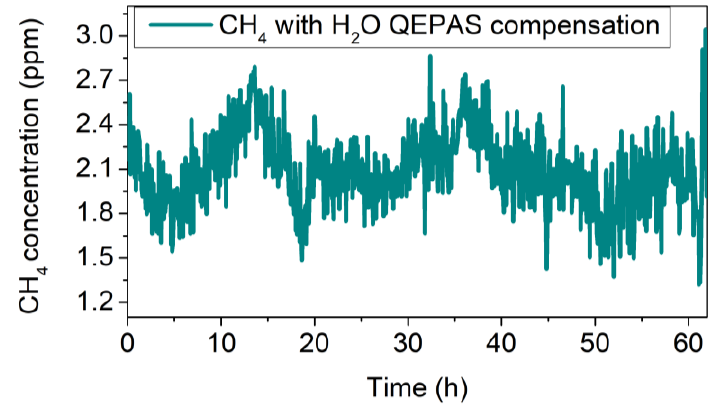
Figure 9. Methane QEPAS signal after water compensation using the H 2 O QEPAS signal.